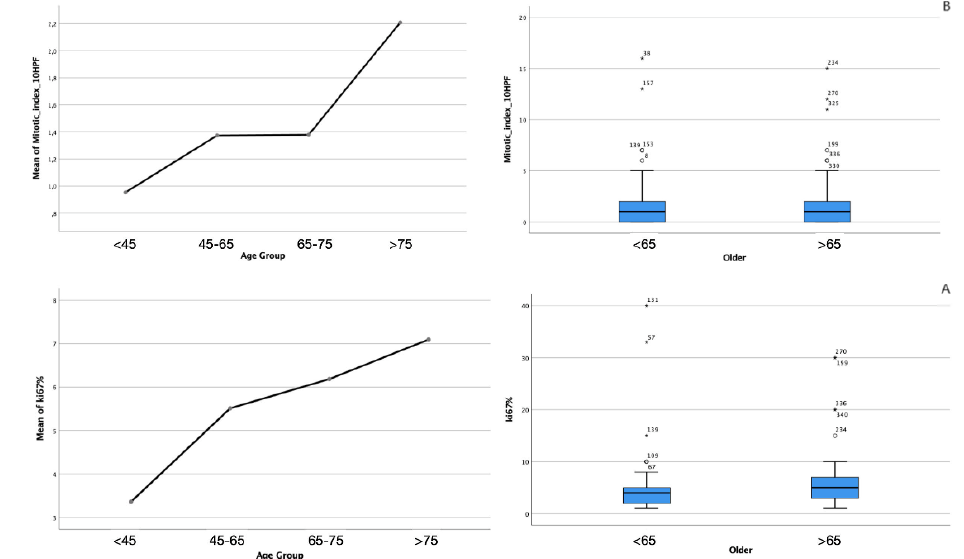
Figure 3. ( A ) ANOVA study performed analyzing ki-67 values and ( B ) observation of increasing number of mitoses per 10 HPF shows a progressive increase with increasing age. This finding does not correlate with grading or radiological features.